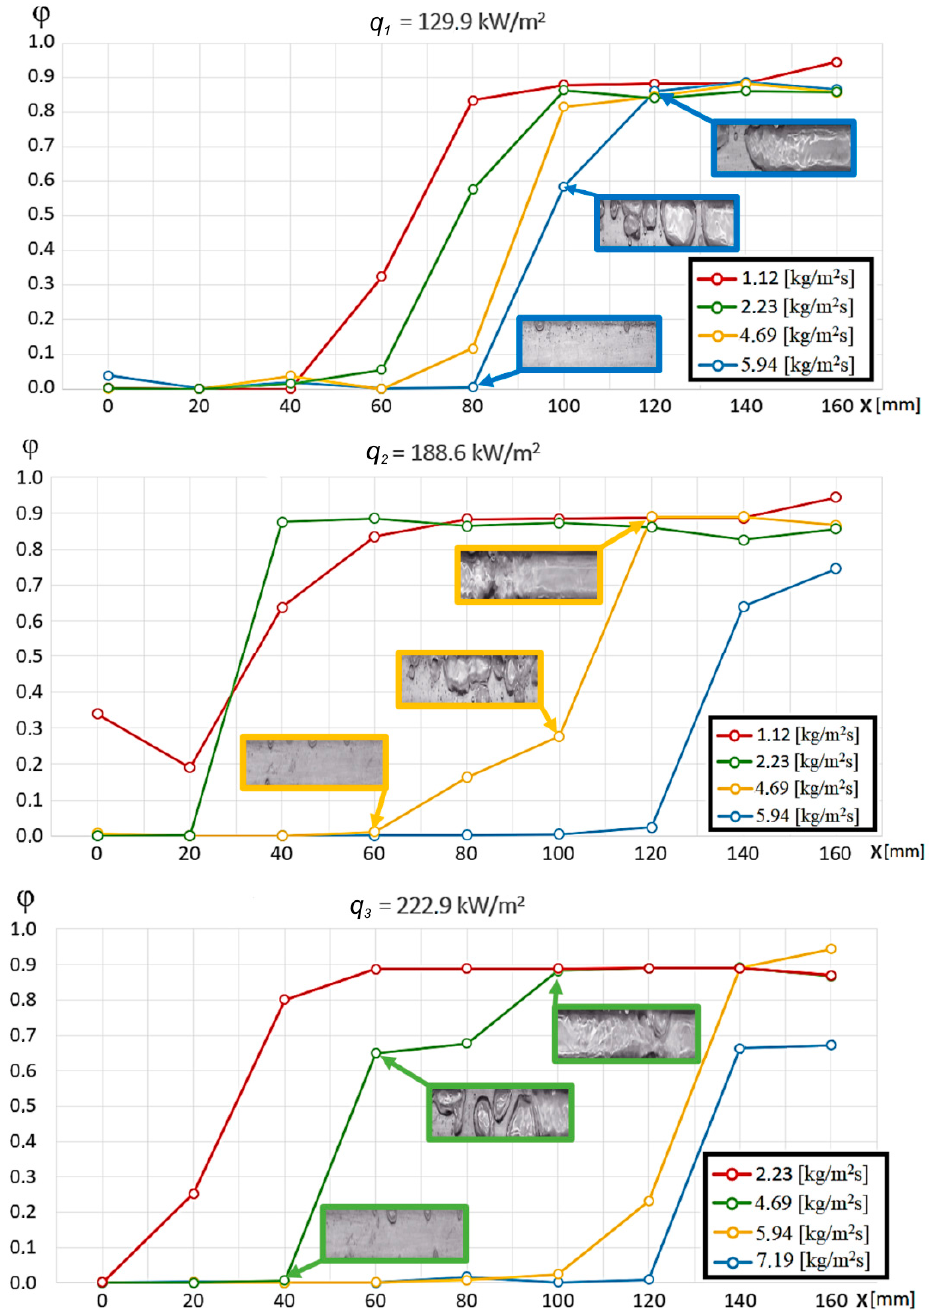
Figure 11. Dependence of the local void fraction for water on the distance from the entrance to the horizontal mini-channel for variable heat fluxes and mass fluxes, q 1 < q 2 < q 3 . The color of the frame around the photo of the two-phase flow structure represents the color of the corresponding polyline curve in the graph.